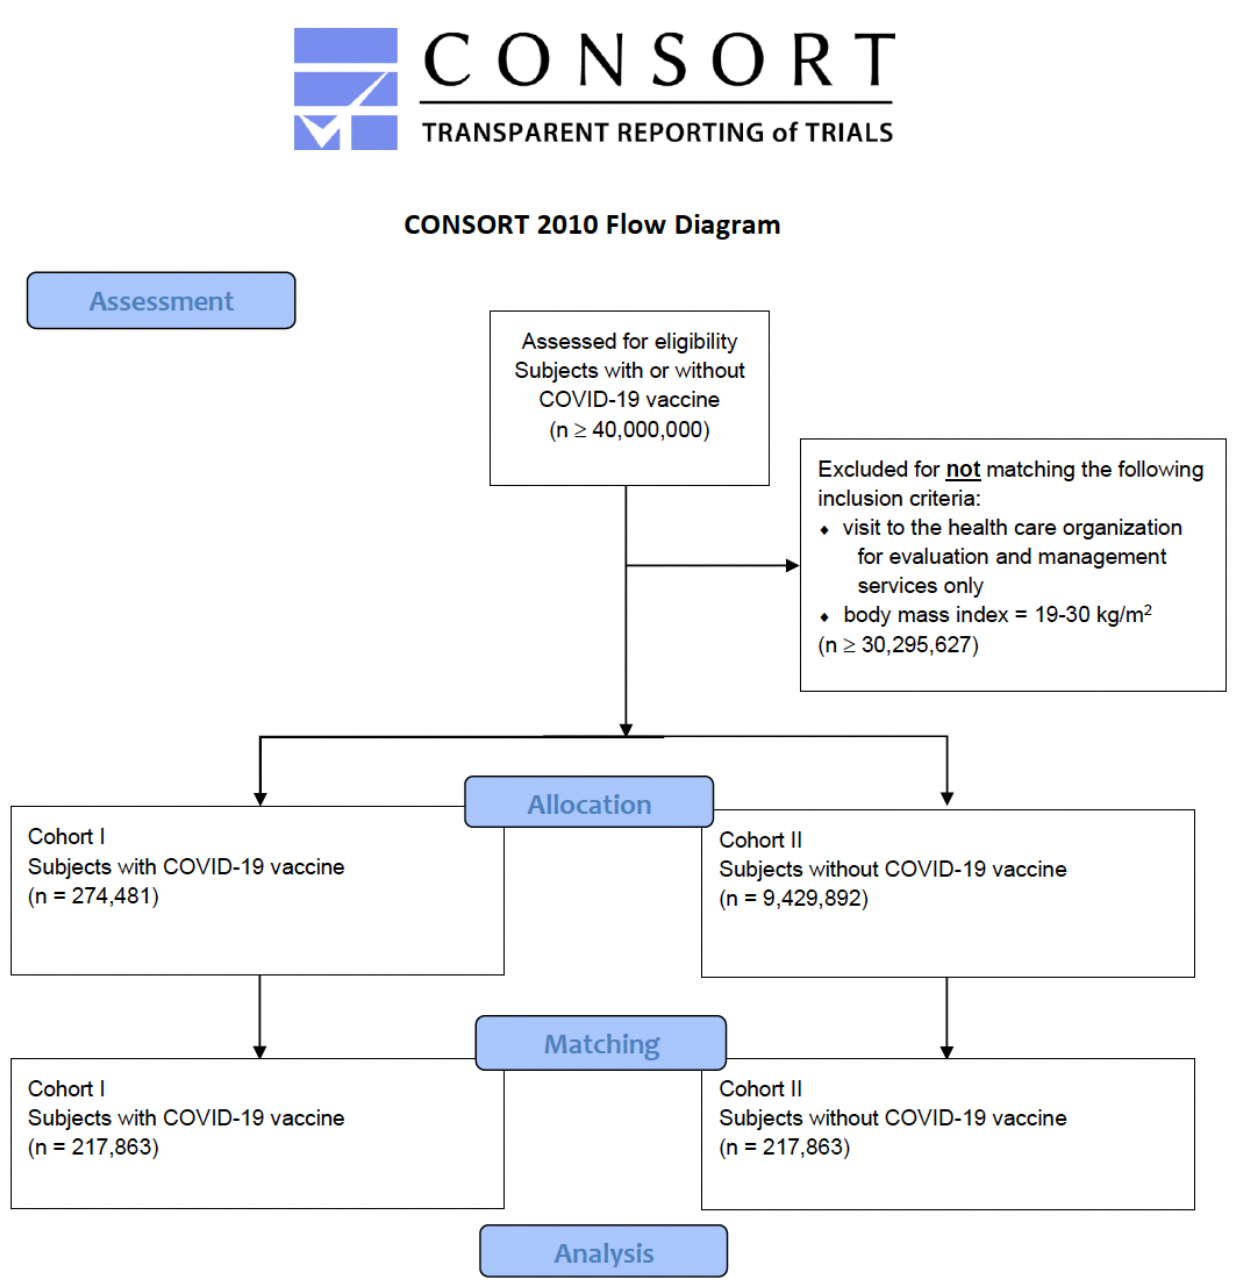
Figure 2. Modified CONSORT flow chart. Note that the number of eligible subjects was 